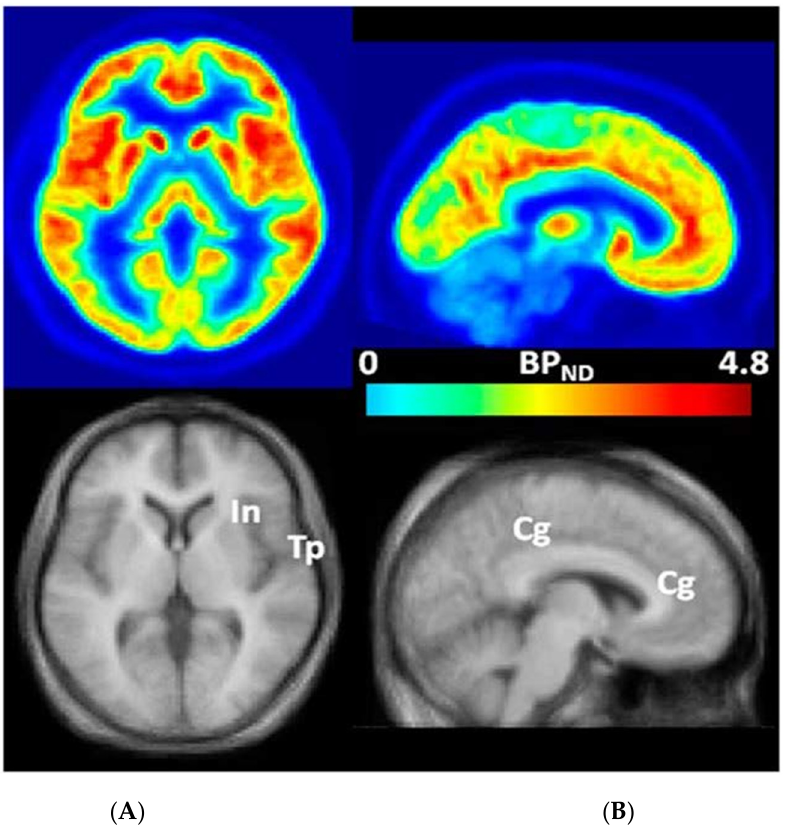
Figure 2. Transaxial ( A ) and sagittal ( B ) non-displaceable binding potential (BP ND ) [69] images of 3-[ 18 F]fluoro-5-(2-pyridinylethynyl)benzonitrile ([ 18 F]FPEB) (top) and matching magnetic resonance (MR) images (bottom) in statistical parametric mapping (SPM) [60,70] standard space. Regions with high BP ND values, namely, insular (In), temporal (Tp), and cingulate (Cg) cortices, are indicated on co-registered MR images [60,70]. This research was originally published in JNM . Wong DF, Water-